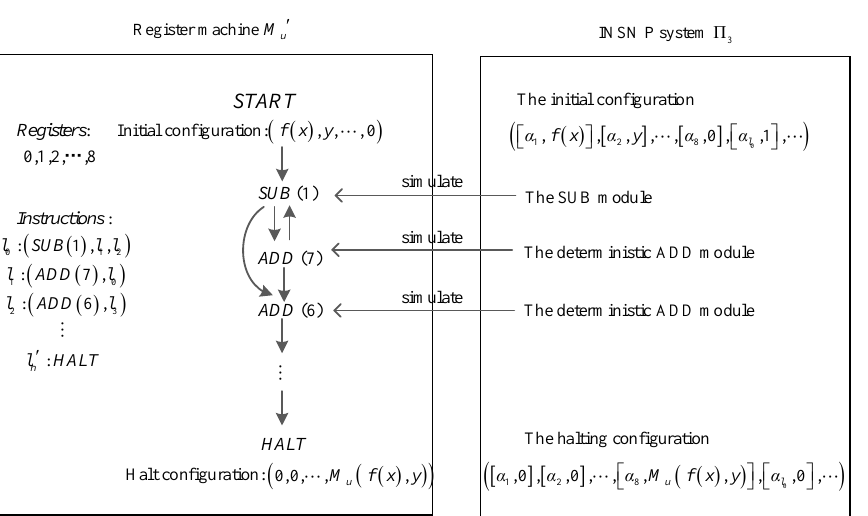
M  . Figure 12. An illustration of using NSNVC P system Π (cid:48) u u